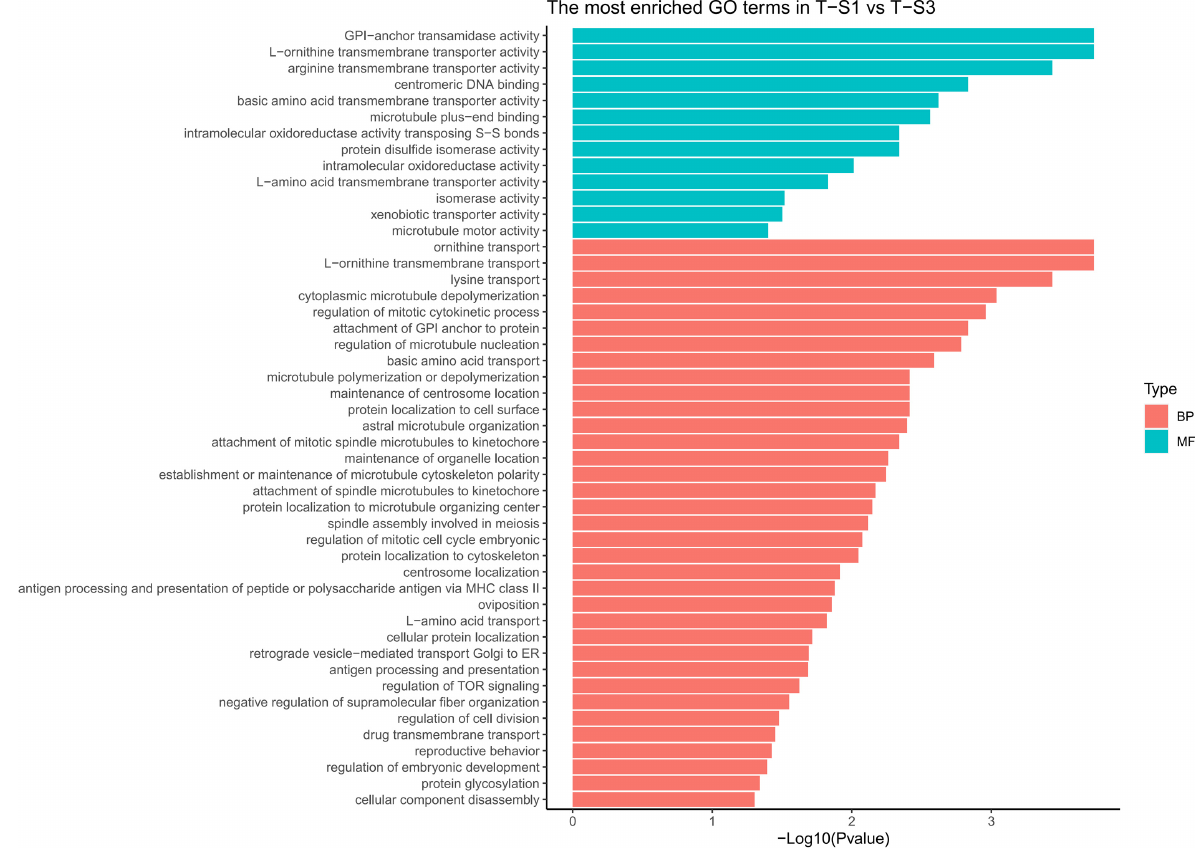
FIGURE 7 | Histograms of the enriched biological processes (BP) and molecular functions (MF) from the genes with differentially methylated positions in individuals from the depth treatment samplings in T-S1 vs. T-S3 (T-S1, T-S3 = depth treatment at sampling times 1 and 3,